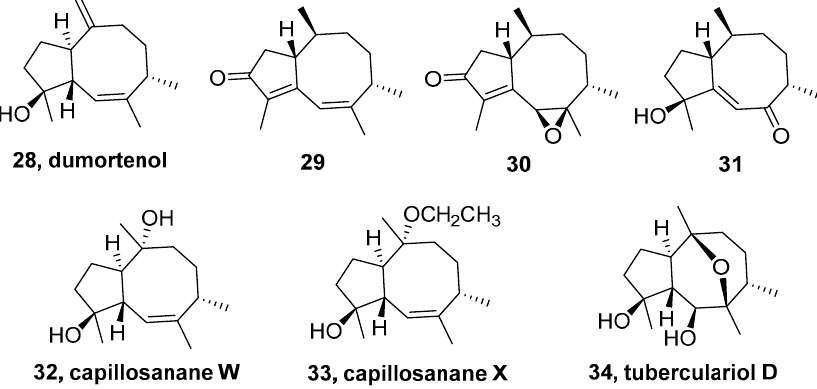
Figure 4. Structures of dumortane-sesquiterpenoids.